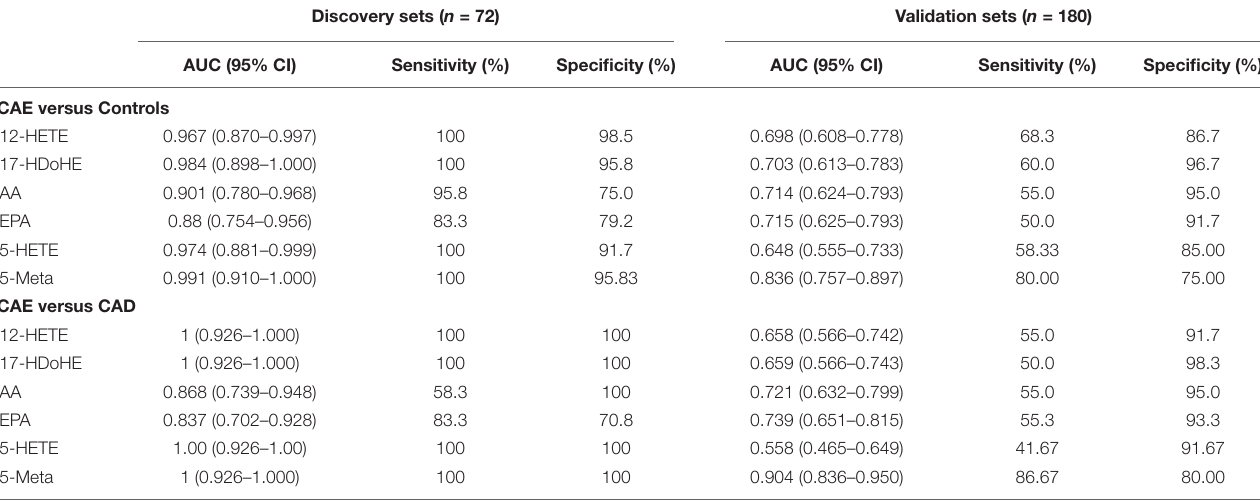
TABLE 2 | Results of measurement of the serum metabolite panel in the diagnosis of CAE. Discovery sets ( n = 72) Validation sets ( n =